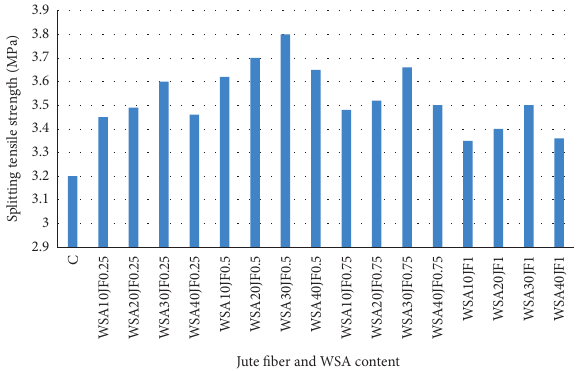
Figure 7: Splitting tensile strength of mixture containing jute fiber and WSA.